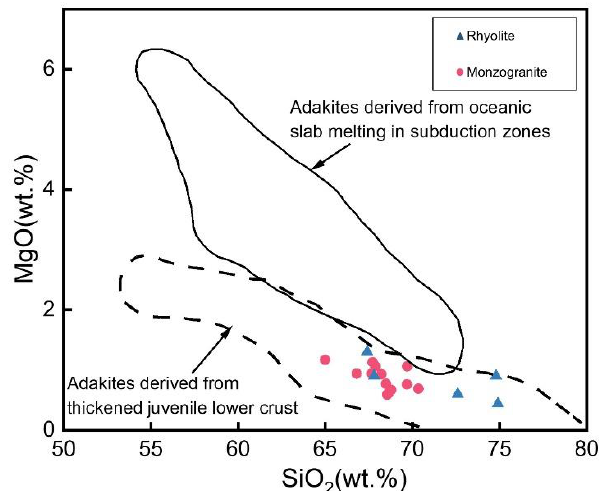
Figure 8. Correlation diagrams of Th/La ( a ), Th/Nd ( b ), Th/Sm ( c ), Th/Y ( d ) vs. Th for the Demingding monzogranites and rhyolites. Data sources: Qulong from [61]; Jiama from [62].